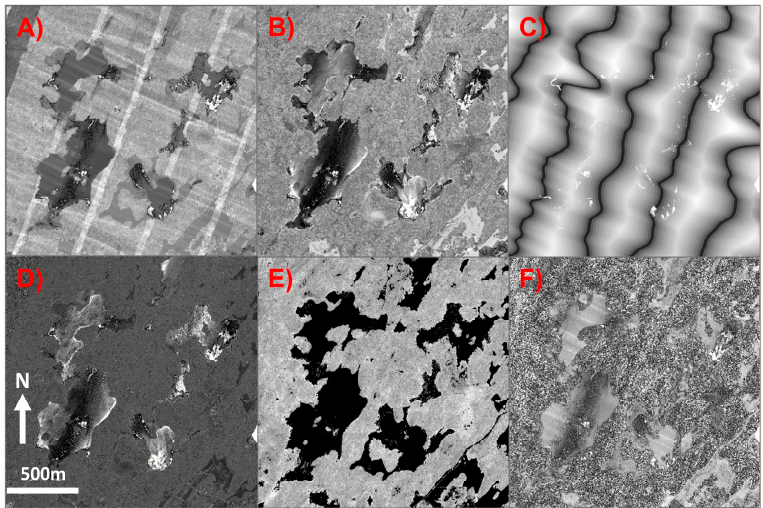
Figure 5. Flow chart illustrating the tiered decision tree methodology used for classifying water using LiDAR data.